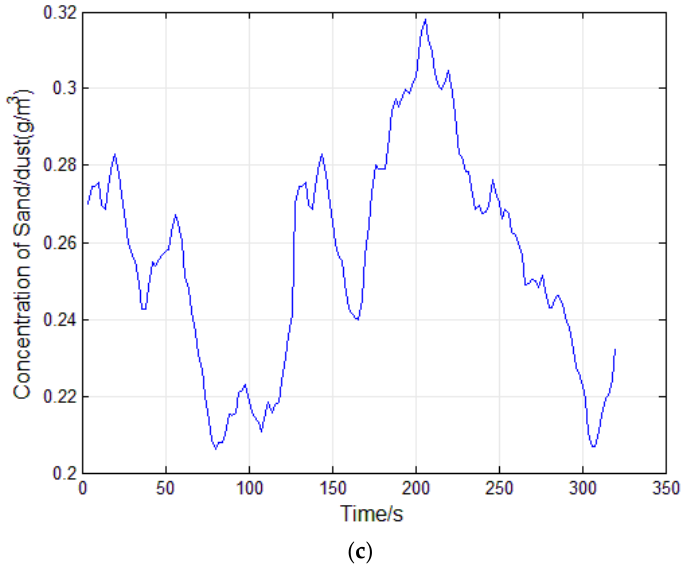
Figure 12. ( a ) Temperature variation of the test section in the low sand environment; ( b ) wind speed of the test section in the low sand environment; ( c ) sand concentration of the test section in the low sand environment. Table 4. Commissioning Results of 18m/s Wind Speed, High Temperature and Low Sand.